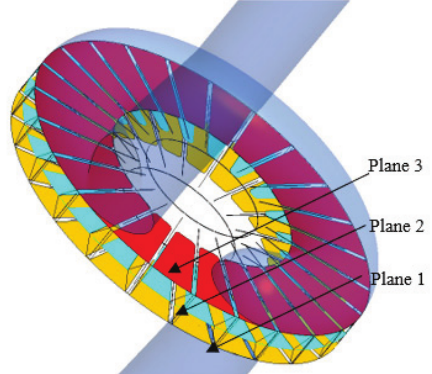
Mathematics 2020 , 8 , 624 Figure 21. Three axial planes on the impeller. Figure 21. Three axial planes on the impeller.